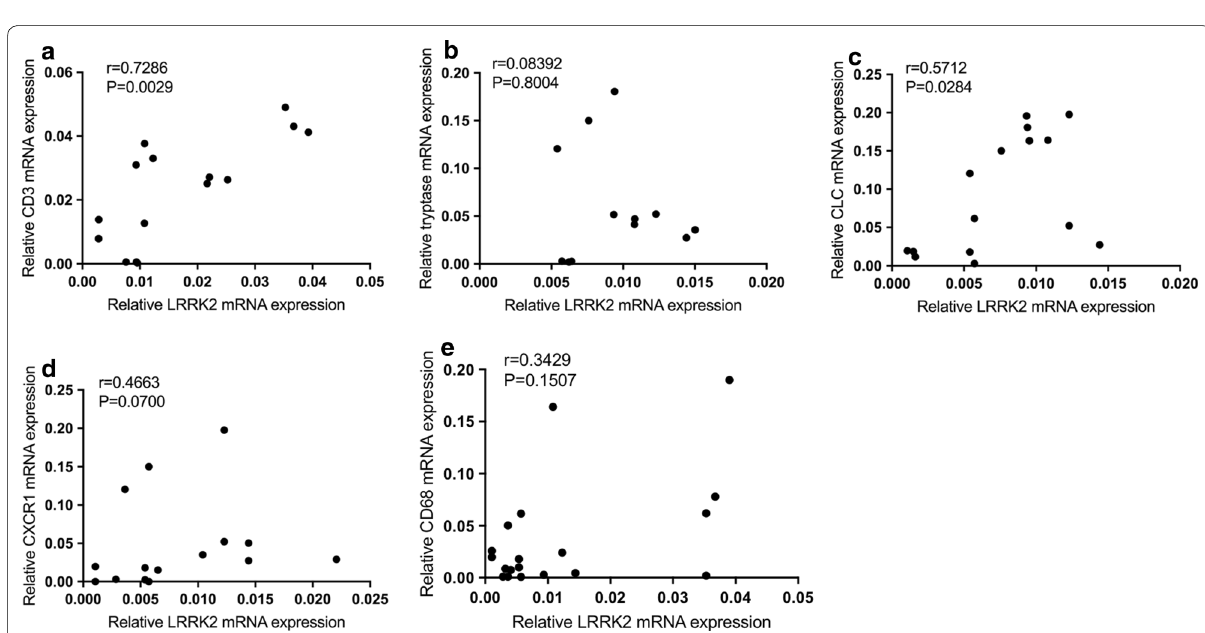
Fig. 3 Correlation of LRRK2 with cell specific markers in nasal mucosa of CRSsNP patients ( a – e ); the expression of LRRK2 and cell specific markers was analyzed by real-time PCR. The correlations were assessed by using the Spearman rank